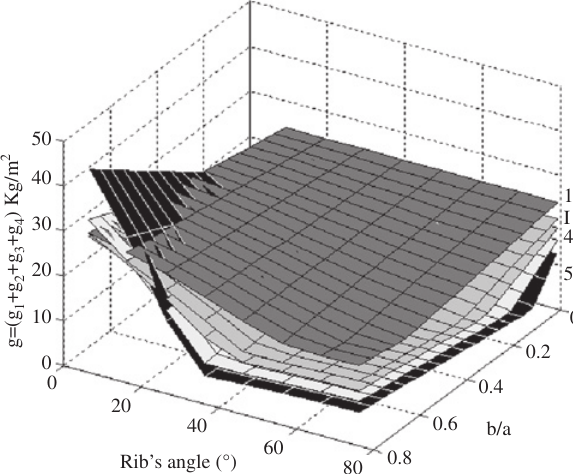
Figure 10 Dependency of the structure mass ( g ) on rib’s angle ϕ and b / a [surfaces 1–4 correspond to various values of allow- ε = and surface 5 corresponds to able axial strain ε and 0.5% x y constraint (24)].